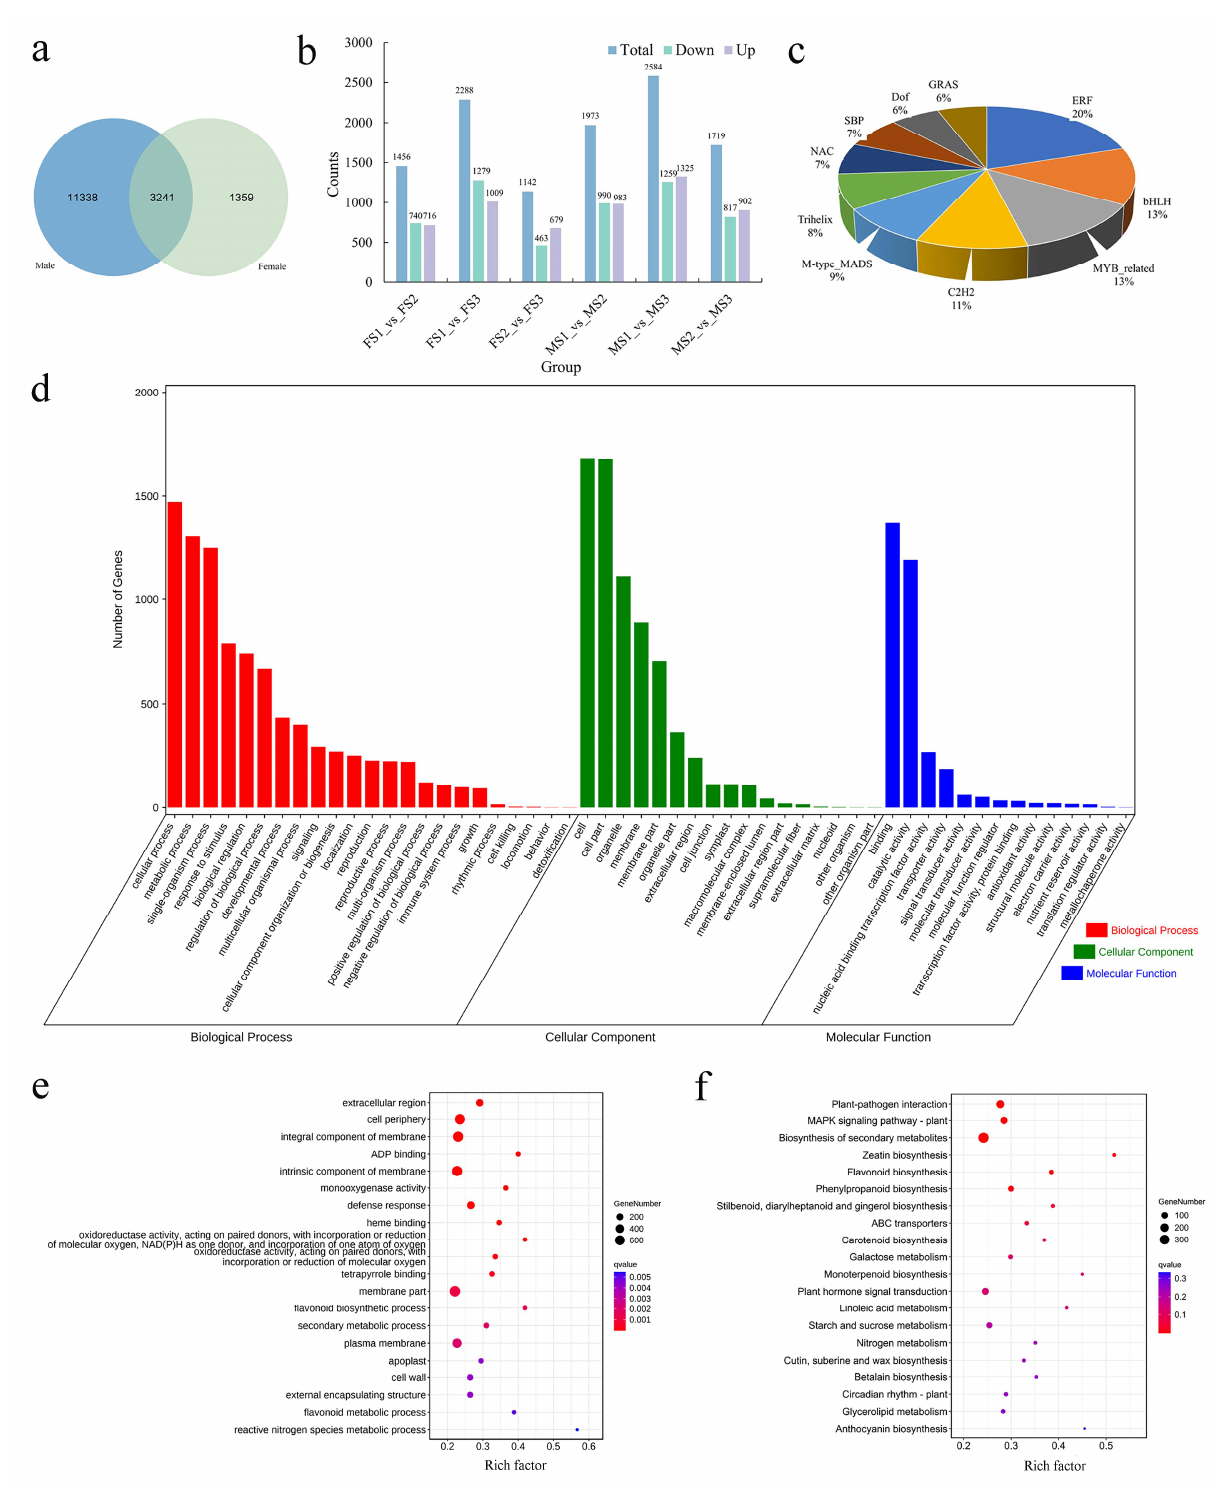
Figure 5. Preliminary analysis of the biological function of the common DEGs during the develop- mental male and female flower. ( a ) Venn diagram of DEGs obtained from male and female flower; ( b ) the statistical analysis of total, up-regulated and down-regulated DEGs in different comparison groups; ( c ) the pie chart displaying the first ten TFs in the common DEGs; ( d ) level-2 GO functional classifications of all the common DEGs; ( e ) GO enrichment analysis for the common DEGs; ( f ) KEGG enrichment analysis for the common DEGs.